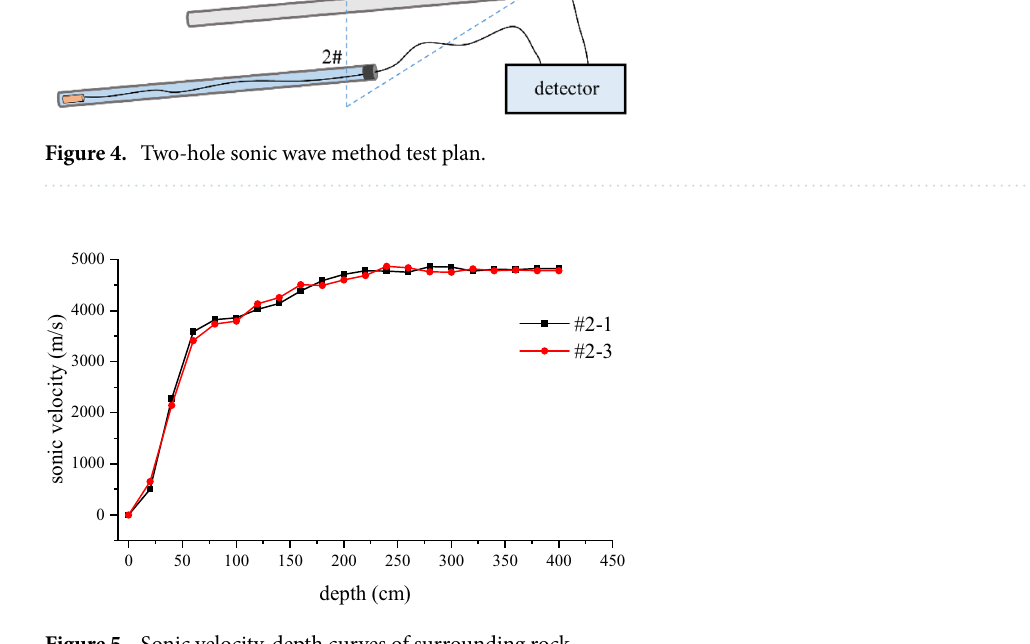
Figure 5. Sonic velocity-depth curves of surrounding